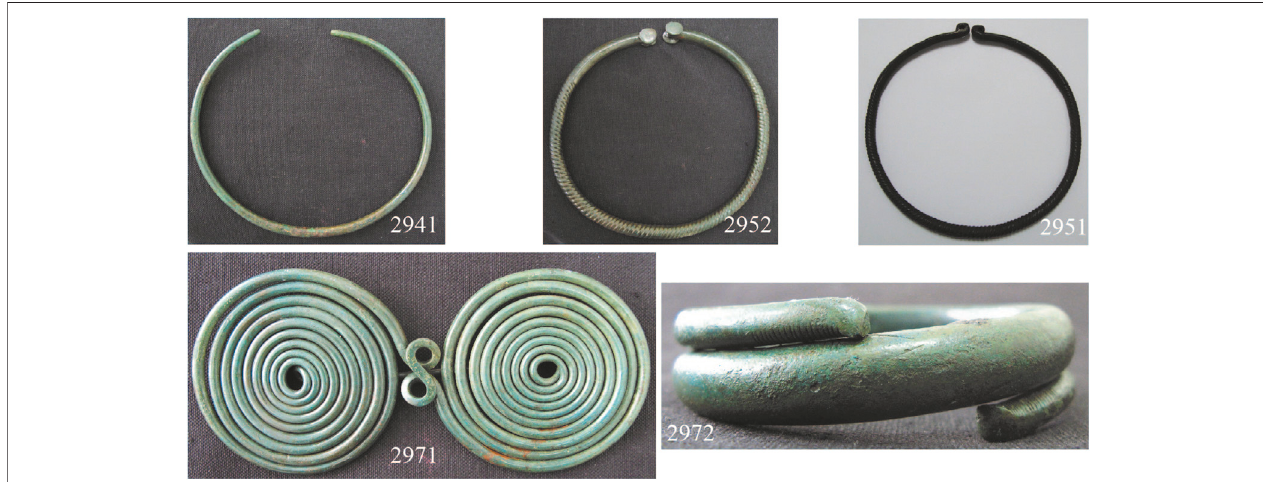
FIGURE 3 | DR images of the bronze adornments.